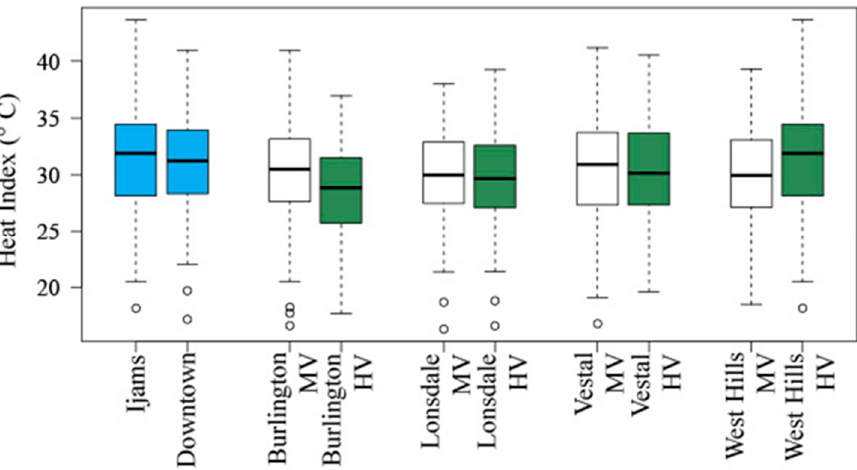
Figure 3. Heat index data range for each station location. Bold horizontal lines indicate median value, boxes represent the upper and lower quartiles of each data set, upper and lower whiskers represent the maximum and minimum values respectively, and open circles represent outliers less than 3/2 times of lower quartile.